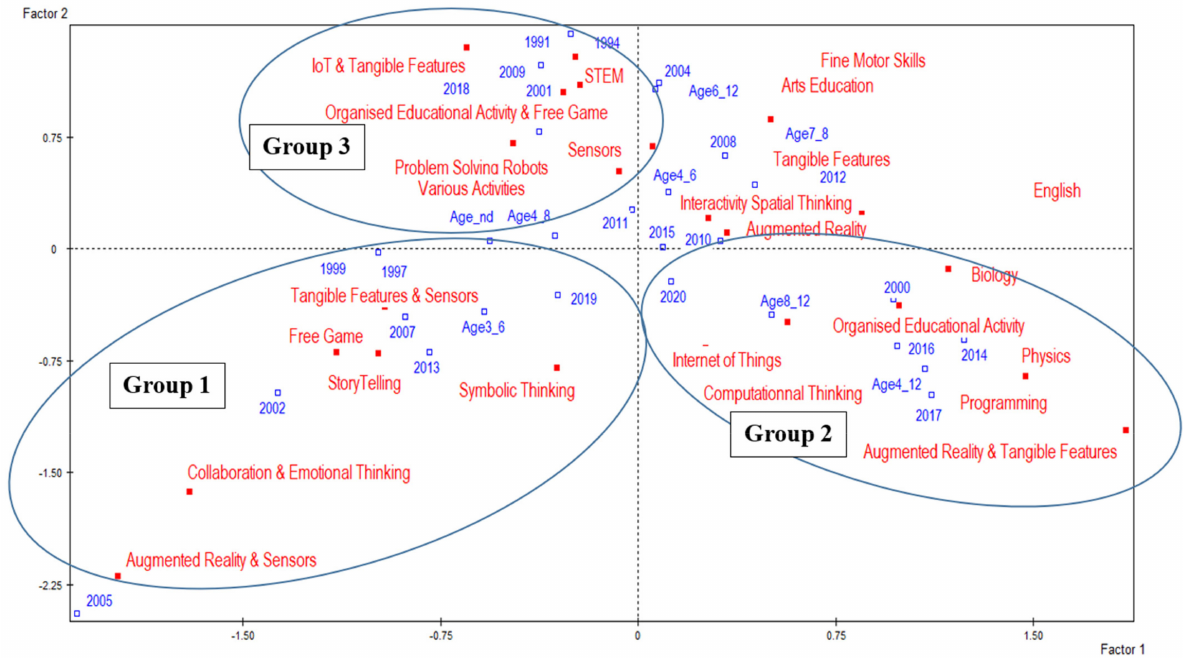
Figure 7. Factorial Plan (Factor/Axis 1 X Factor/Axis